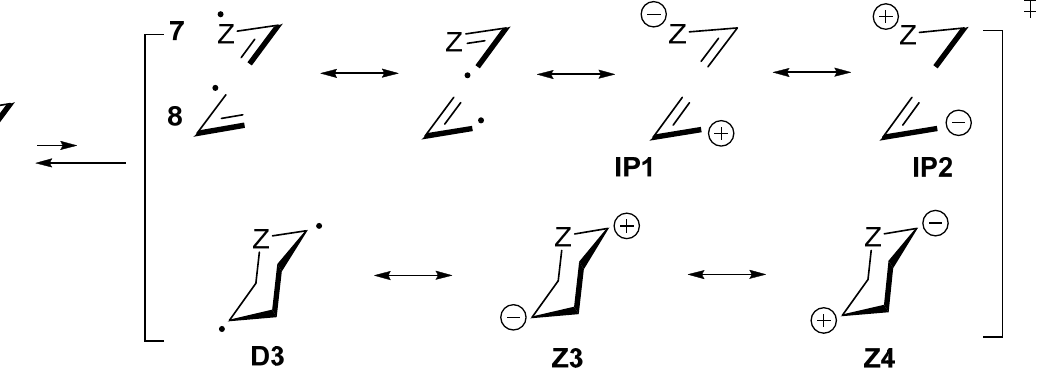
Figure 5. Diradicaloid model for the variable transition states of the (3,3)-sigmatropic rearrangements.